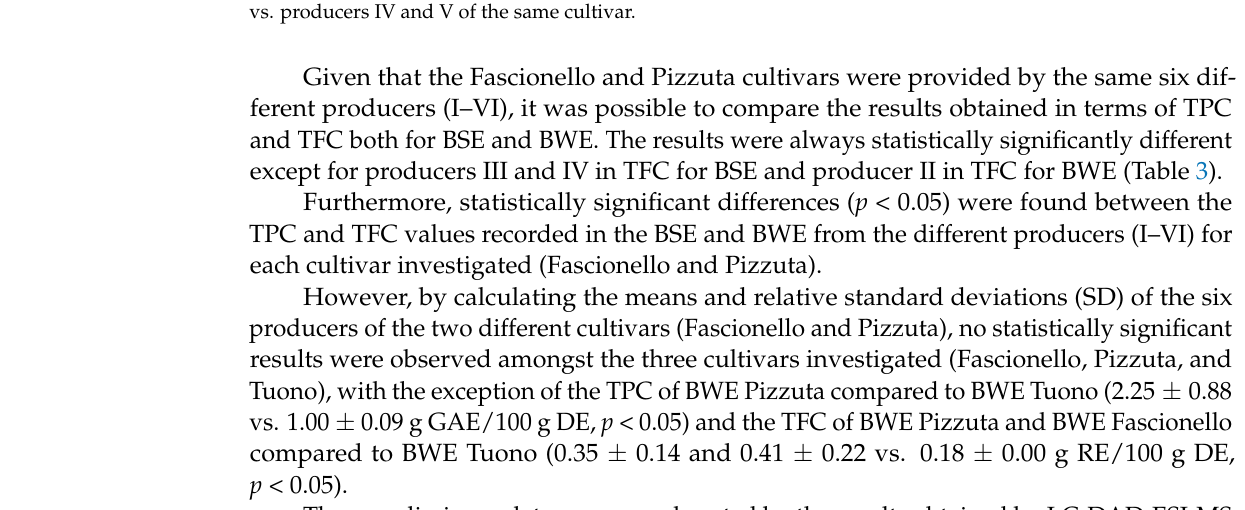
Table 4. The results of the Fascionello and Pizzuta cultivars represent the mean ± SD of the six producers, which provided the BS and BW